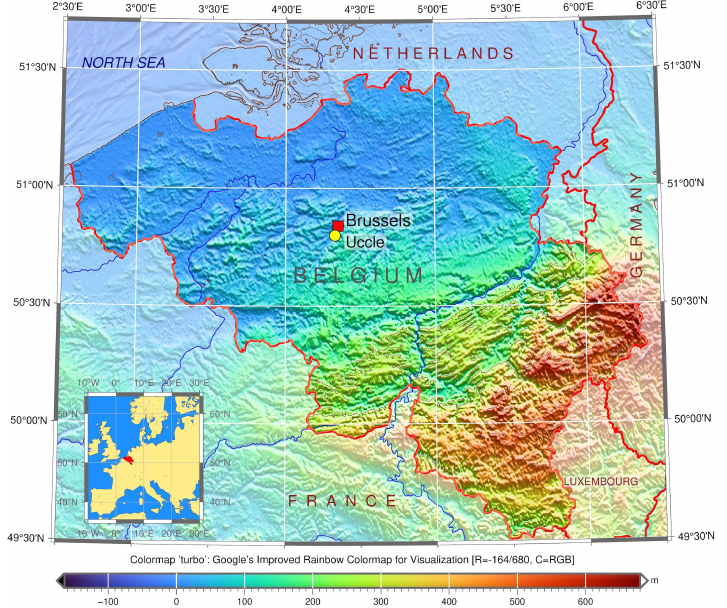
Figure 1. Study area: Location of Uccle seismic station, ROB on the topographic map of Belgium. Software: GMT version 6.1.1, creator: P. Wessel et al. [97], University of Hawai’i at M¯anoa, Honolulu, HI, USA. Cartography source: